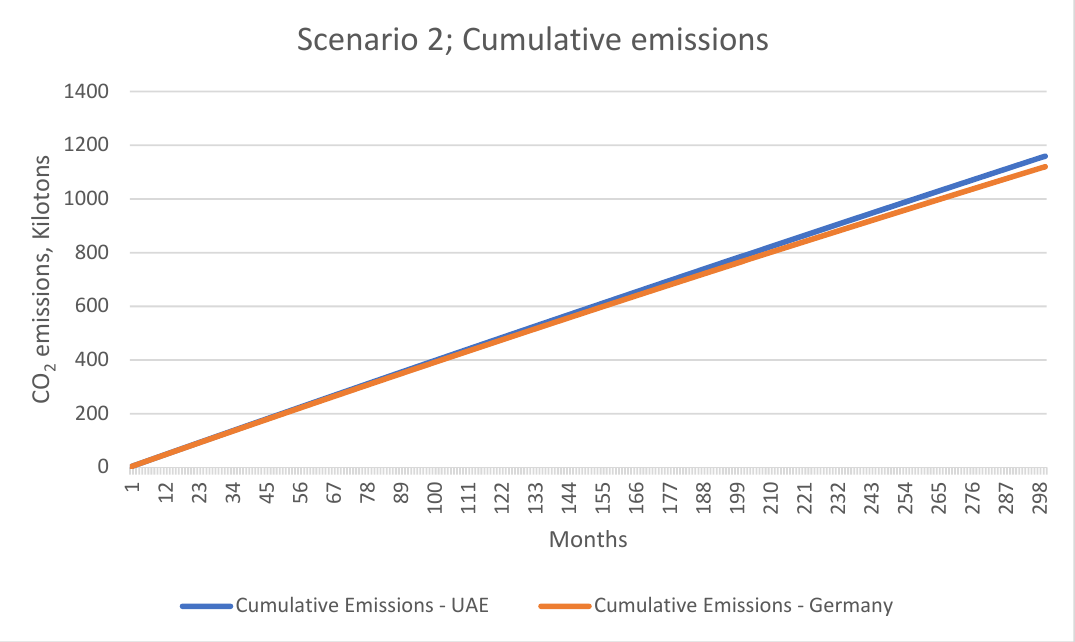
Figure 9. Cumulative emissions through electricity consumption for UAE and DE under scenario 2.